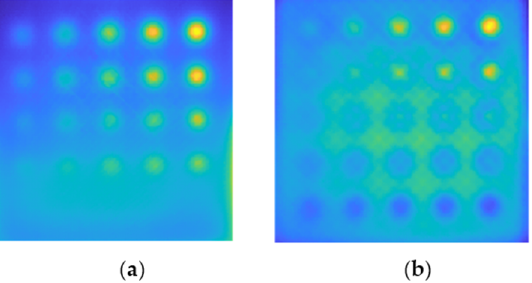
Figure 9. Exemplary experimental results for sample S1 ( a ) and S2 ( b ). The thermograms are ob- tained after the heating process—60 s of the